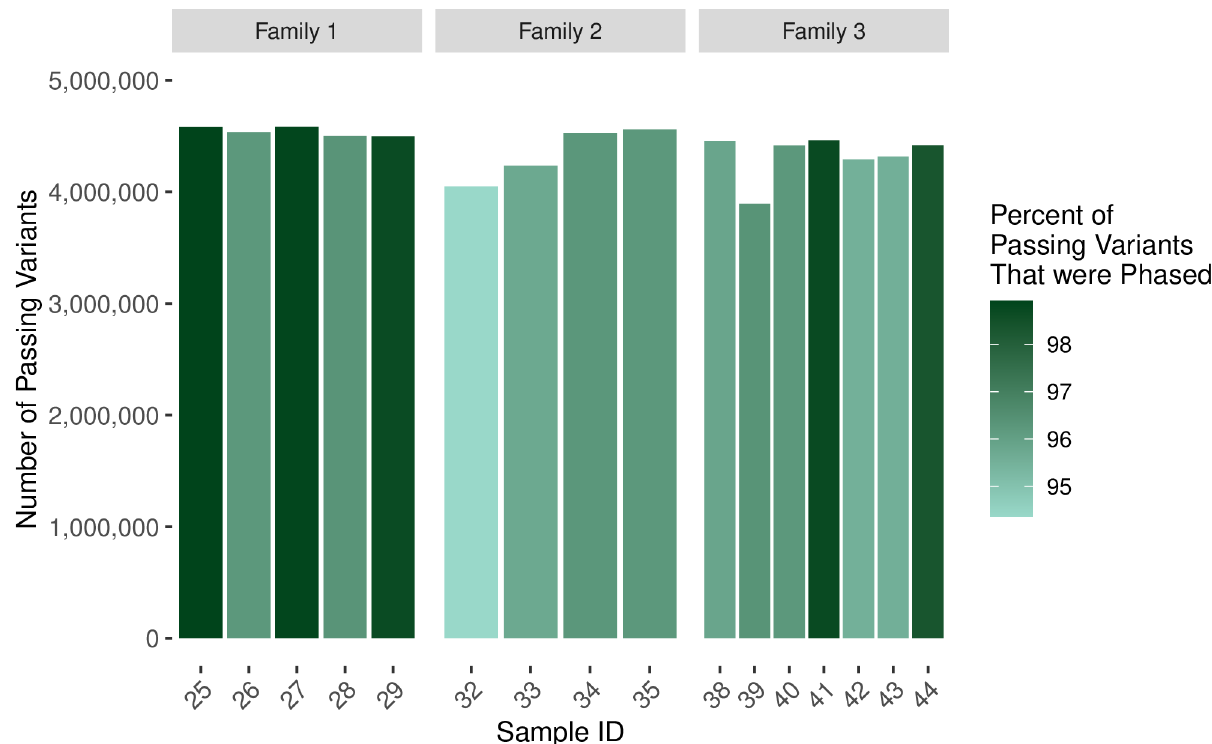
Fig 2. The number of passing variants output from Long Ranger and the percentage of those passing variants that were phased. Passing variants were those that had a “PASS” in the filter column of the VCF and a quality score > = 20. These numbers are summarized over all variant categories. In order of the samples listed in the figure, the number of total variants output from Long Ranger per sample was 5.89 x 10 6 , 5.95 x 10 6 , 6.11 x 10 6 , 6.00 x 10 6 , 6.22 x 10 6 , 5.79 x 10 6 , 5.80 x 10 6 , 6.12 x 10 6 , 6.02 x 10 6 , 6.07 x 10 6 , 5.72 x 10 6 , 5.83 x 10 6 , 6.58 x 10 6 , 6.25 x 10 6 , 6.19 x 10 6 , 6.40 x 10 6 .